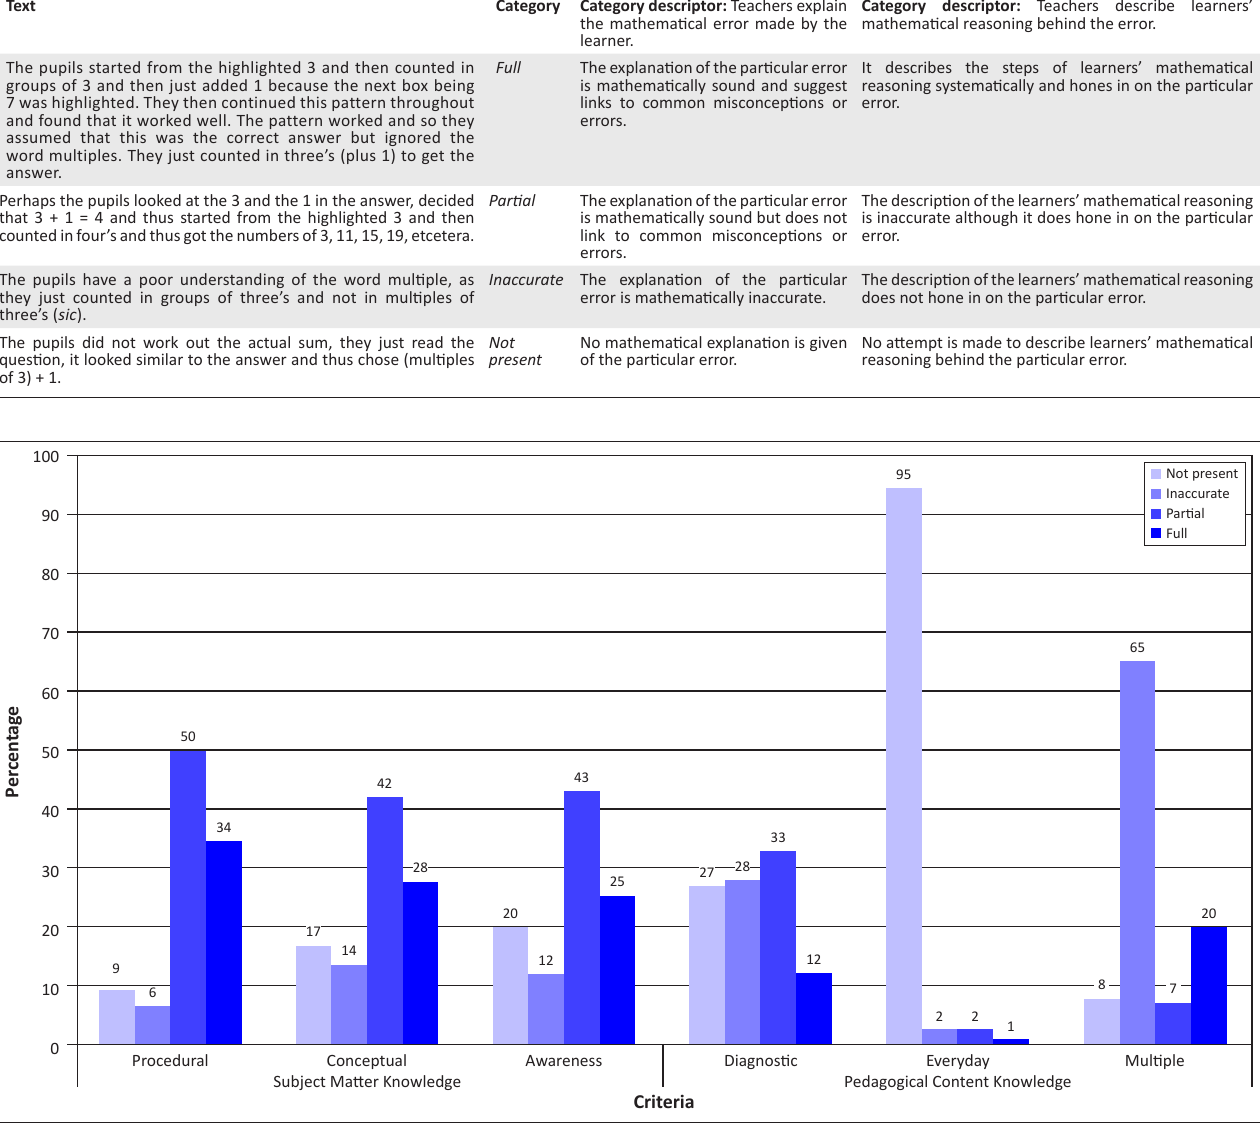
FIGURE 1: Percentage of texts by error analysis